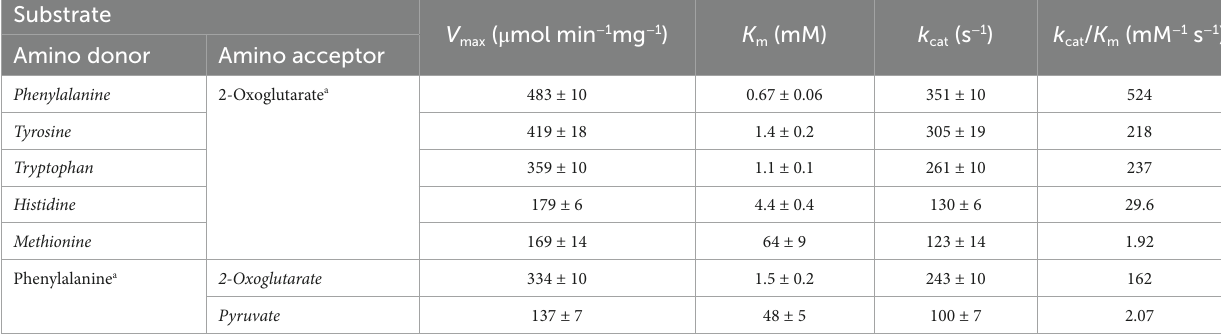
TABLE 1 Kinetic parameters of the aminotransferase reaction catalyzed by the TK0548 protein.